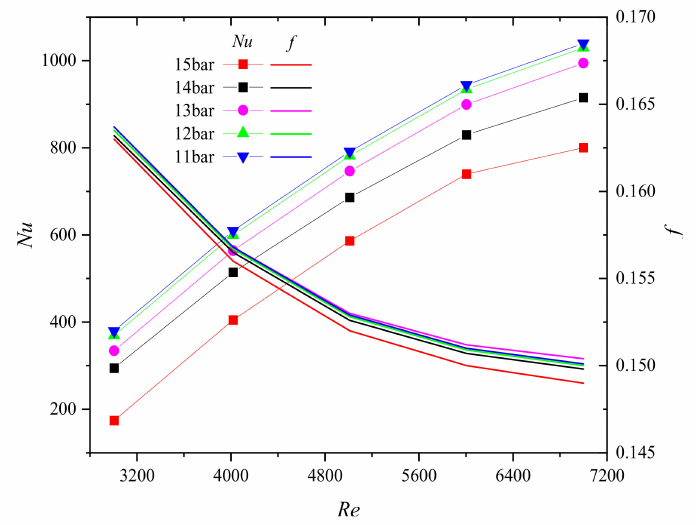
Figure 15. The variation of Nu with Re at the target